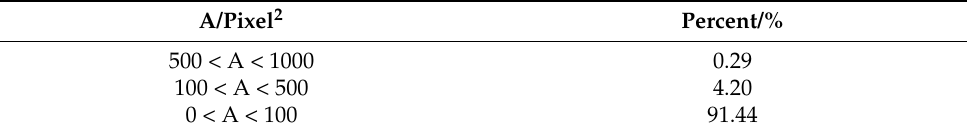
Table 3. The ratio of area A and percent of false positives.